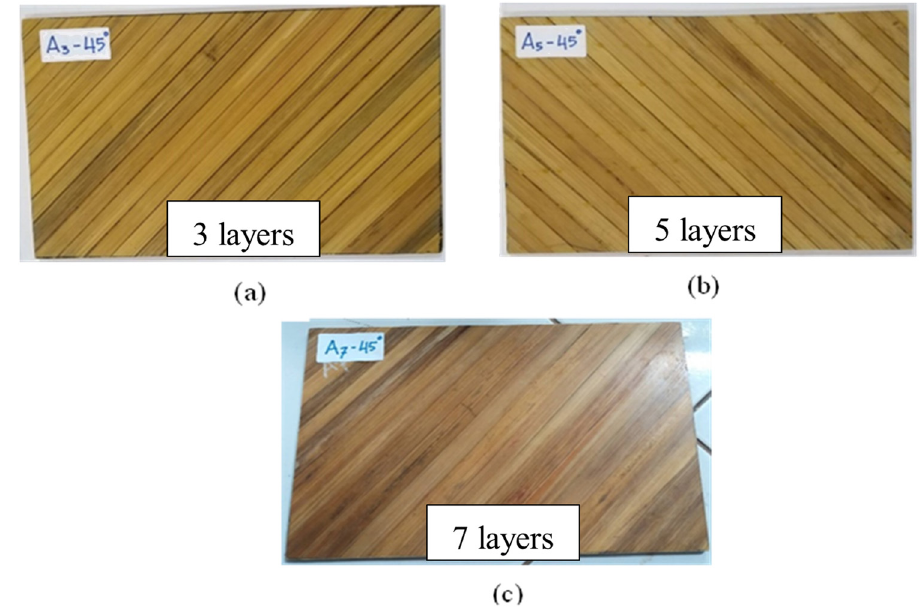
Figure 2: Laminated bamboo – fi breglass boards: ( a ) 3 layers, ( b ) 5 layers, and ( c ) 7